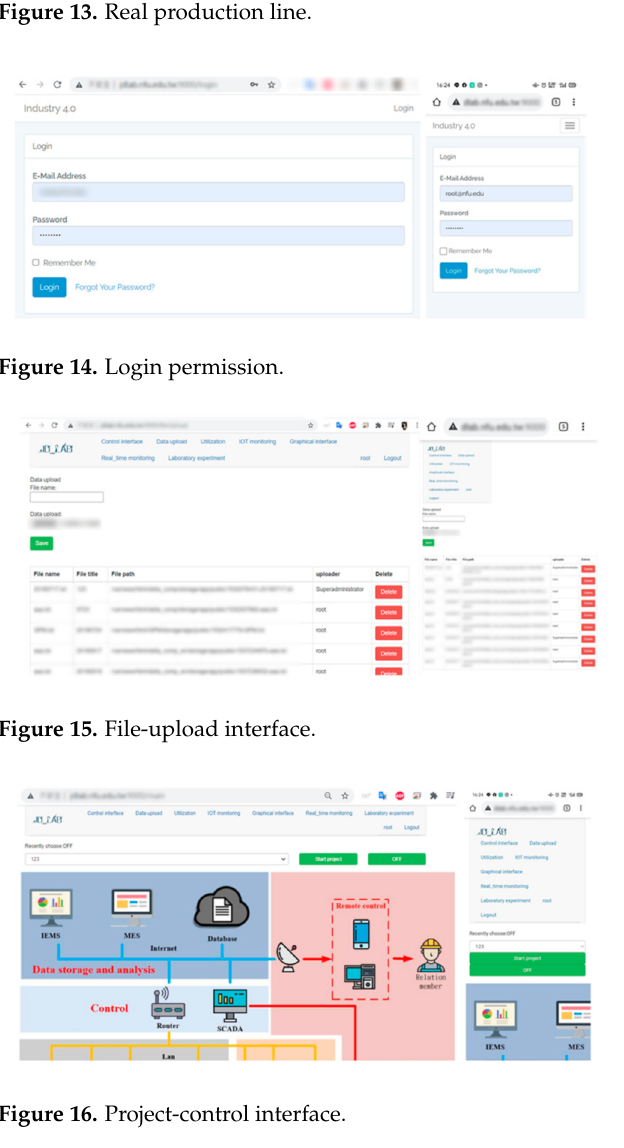
Figure 13. Real production line.